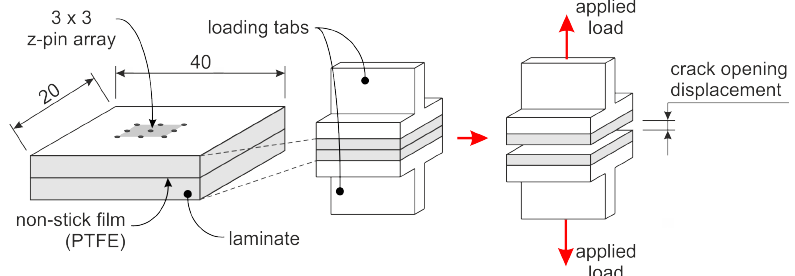
Figure 3. Definition of the z-pin pullout test sample geometry and test